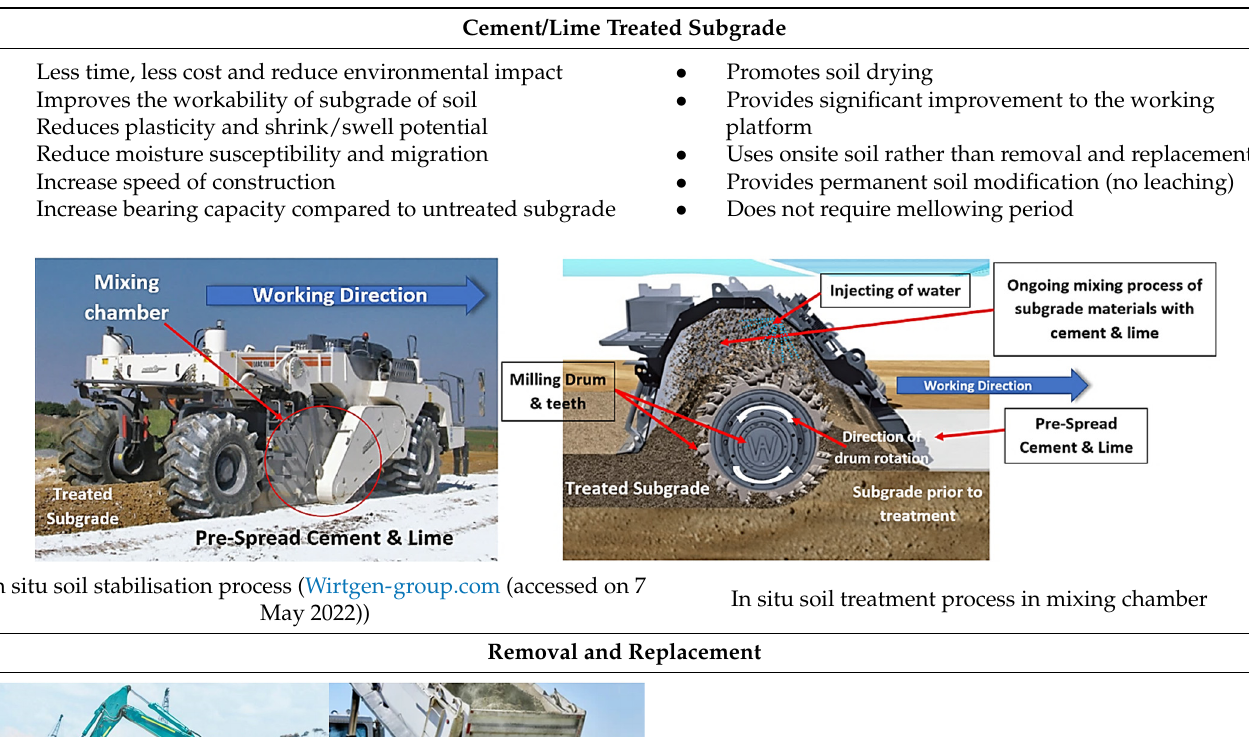
3 Figure 2. The application process of binder agent in real-life road construction.